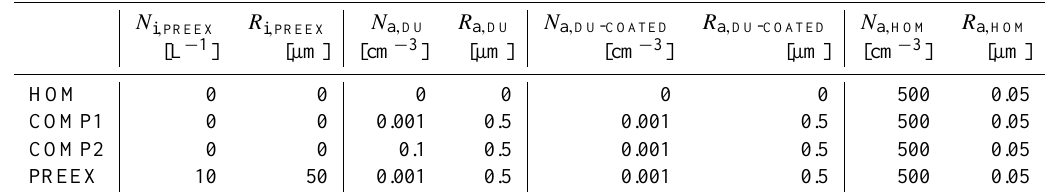
Fig. 1. Temporal evolution of the S i , w ice and newly formed ICNC as simulated by the multi-modal ice nucleation scheme used as a box model for simulation HOM (upper row), COMP1 (second row), COMP2 (third row) and PREEX (last row). Initial conditions are p = 100hPa, T = 210K, S i = 1 . 2, and w = 20cms − 1 . Initial conditions of aerosol properties and pre-existing ice are given in Table 1. The dotted line indicates the ice nucleation events and the dashed line indicates the peak S i .